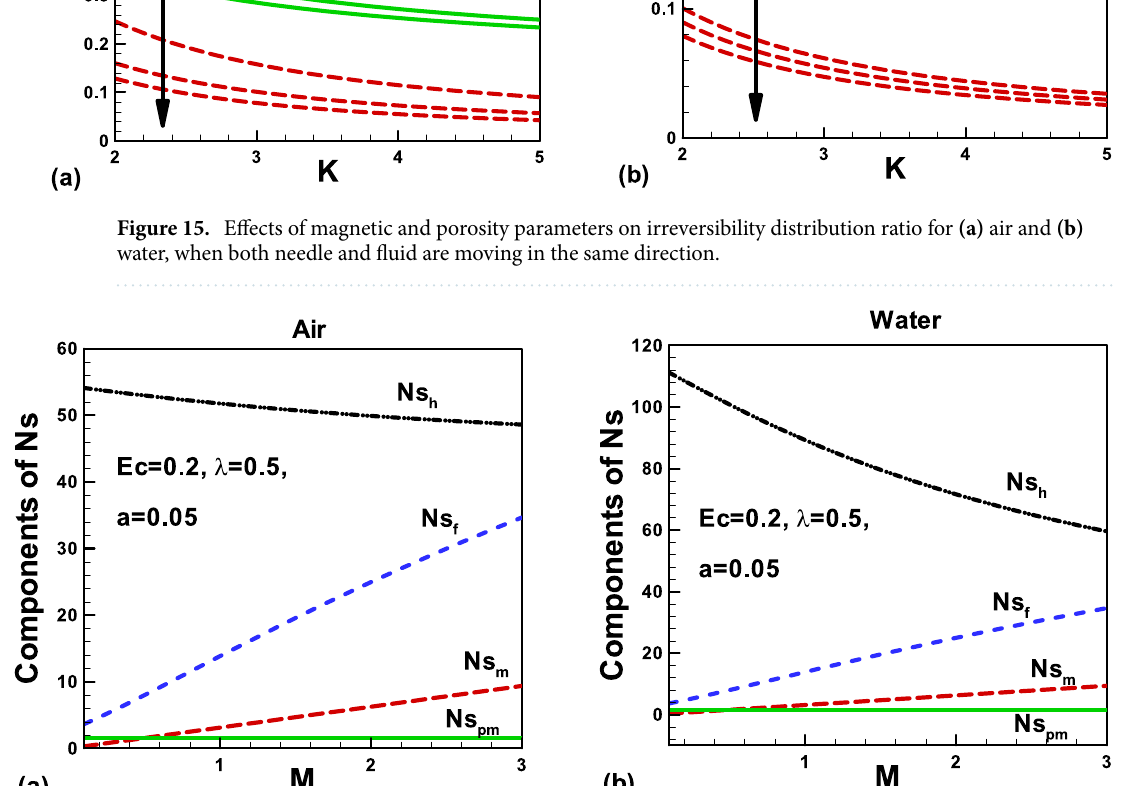
Figure 16. Effects of the magnetic parameter on components of entropy generation rate for (a) air and (b) water, when both needle and fluid are moving in the same